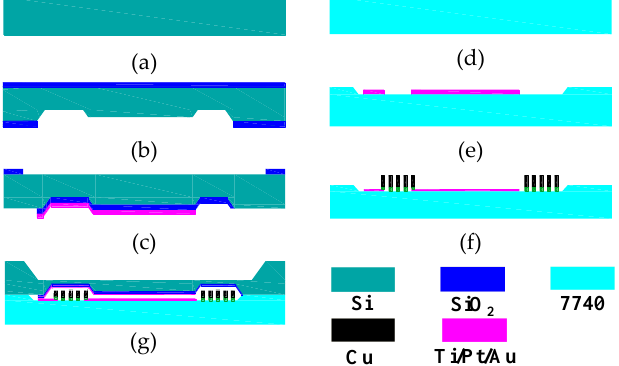
Figure 5. Fabrication process of the pressure sensor. (a) silicon; (b) TMAH etch;(c) upper plate sputter and pattern; (d)7740 glass; (e)lower plate sputter and pattern;(f)planar coil electroplating;(g)anodic bonding.